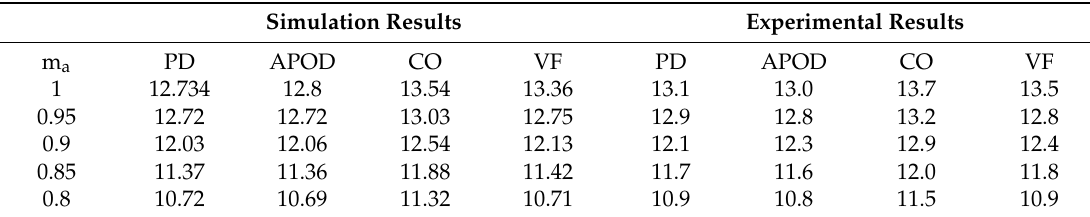
Table 3. V RMS for different modulation indices.